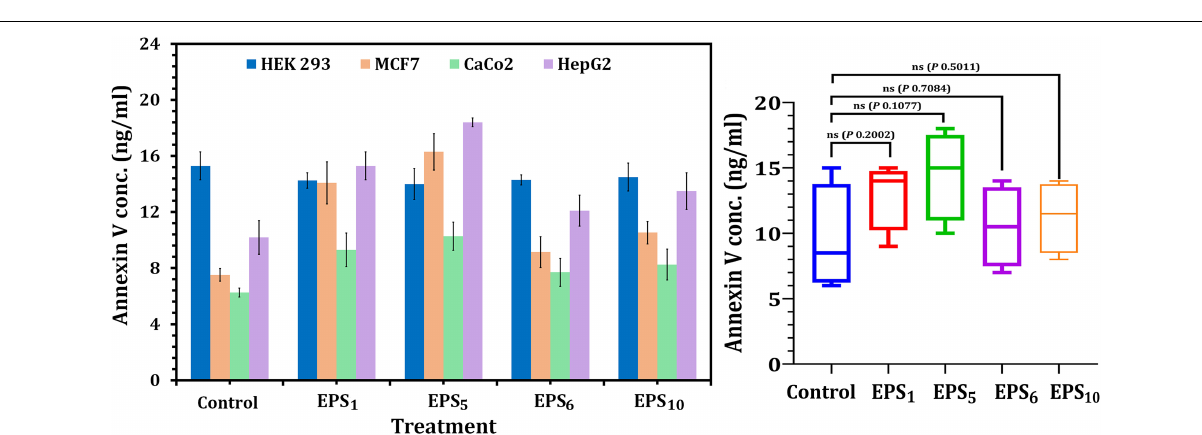
Figure 4 | Apoptosis assessment using annexin V ELISA kit on cancer cell lines. EPS 1 , EPS derived from S. thermophilus DSM 24731; EPS 5 , EPS derived from L. delbrueckii ssp. bulgaricus DSMZ 20081 T ; EPS 6 , EPS extracted from L. fermentum DSMZ 20049, and EPS 10 , EPS derived from B. longum ssp. longum DSMZ